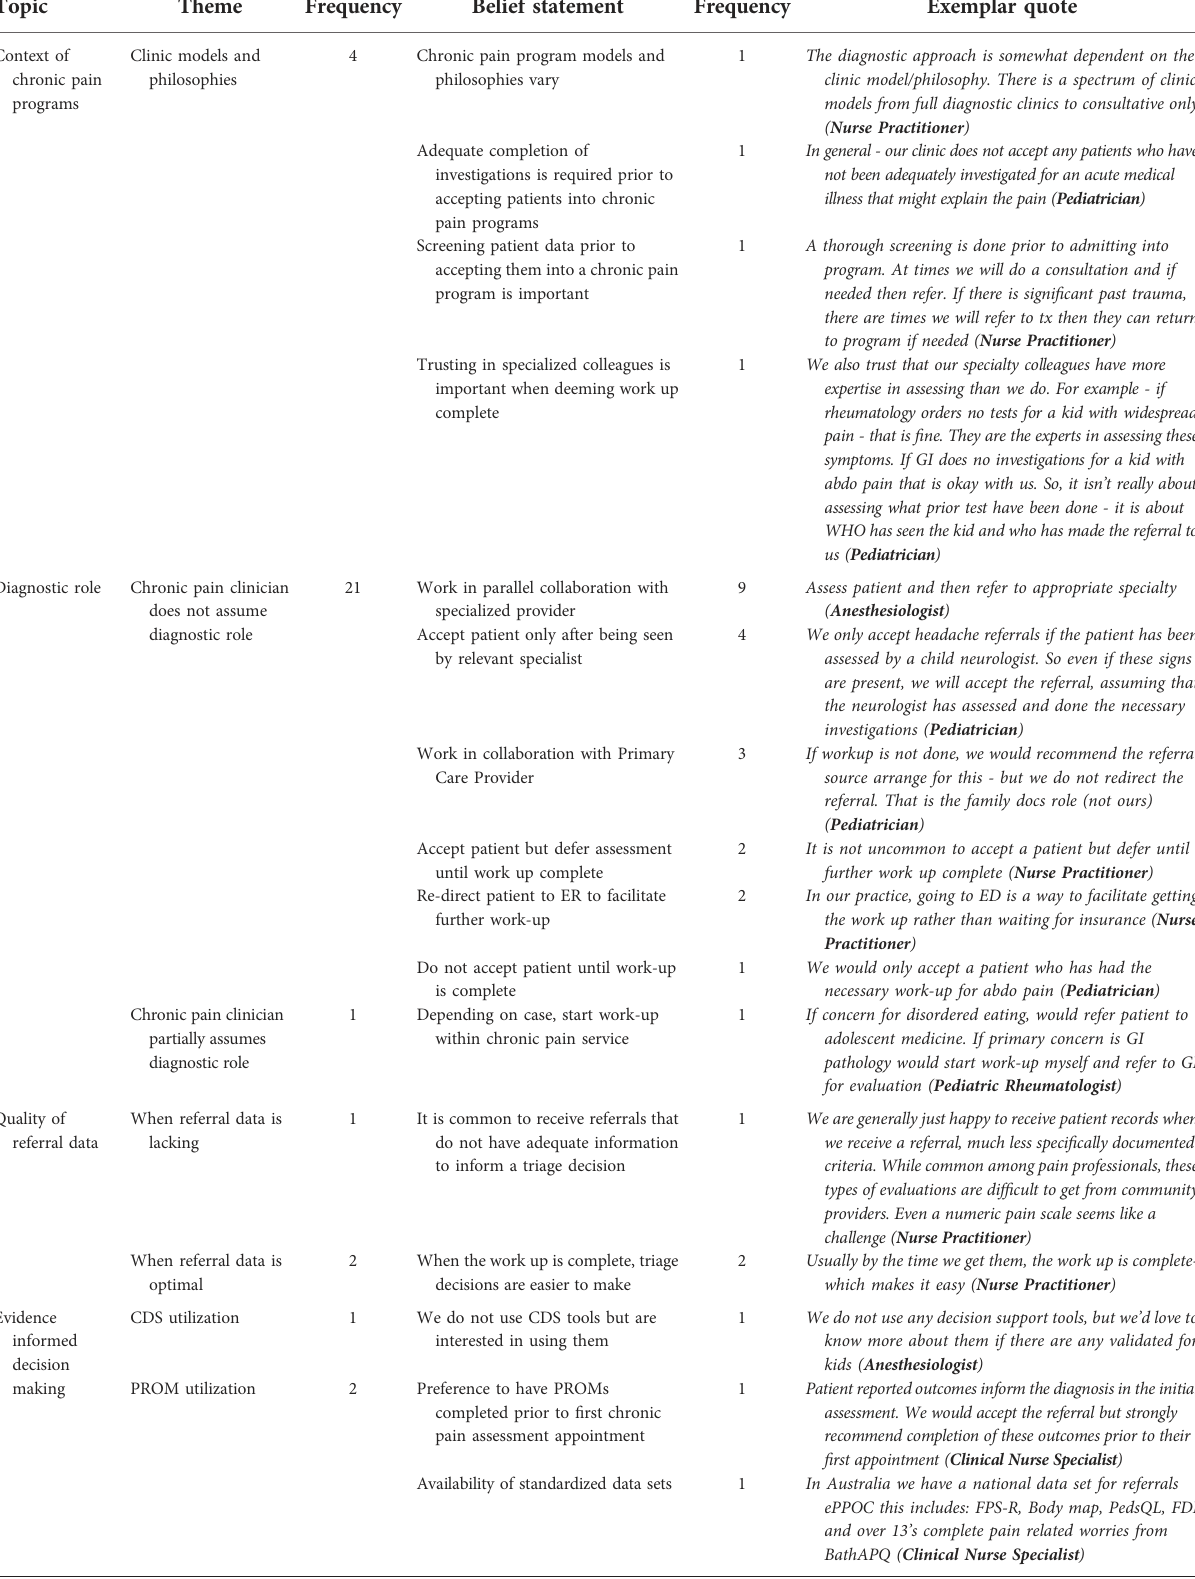
TABLE 5 Supporting qualitative